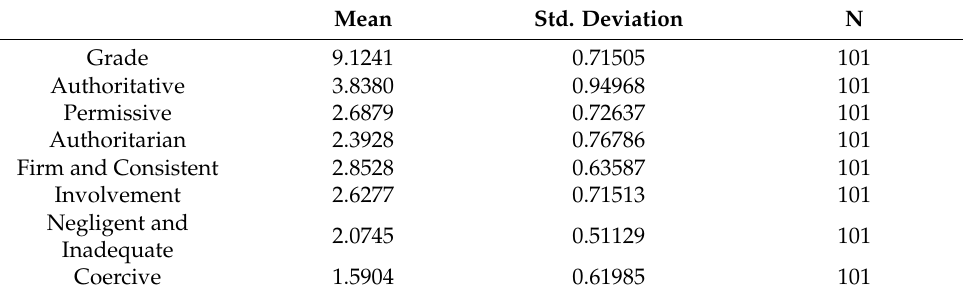
Table 1. Mean scores of parenting typologies.